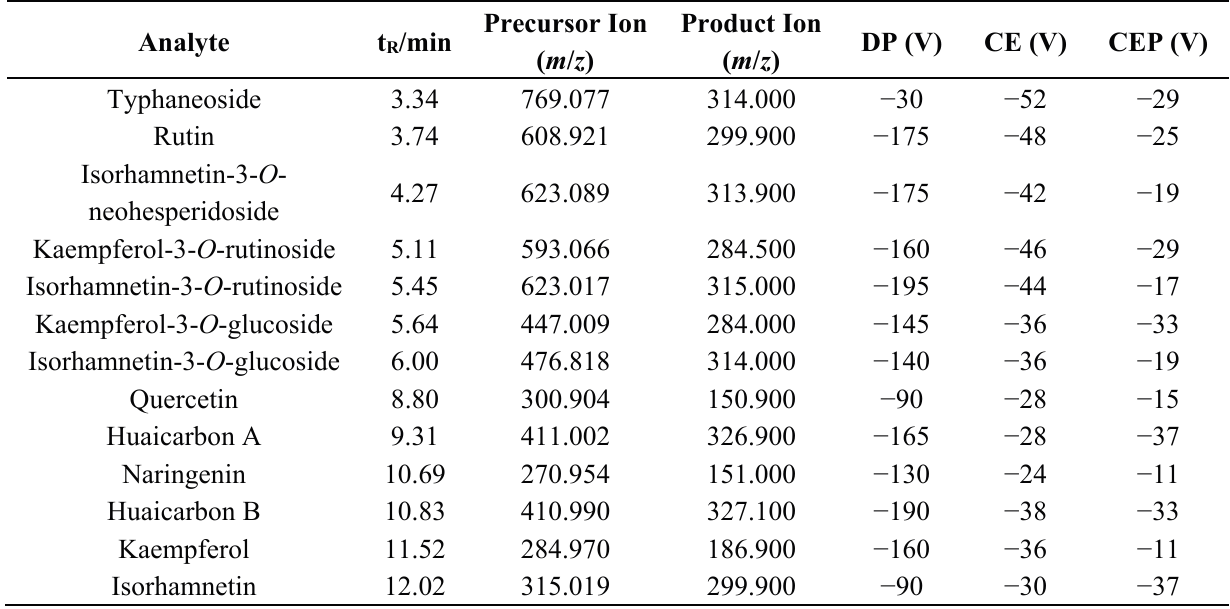
Table 6. LC-MS/MS characteristics of quantified compounds in negative ion mode. The measured precursor ion, product ions, the declustering potencial (DP), collision energy (CE), as well as the cell exit potential (CEP) are